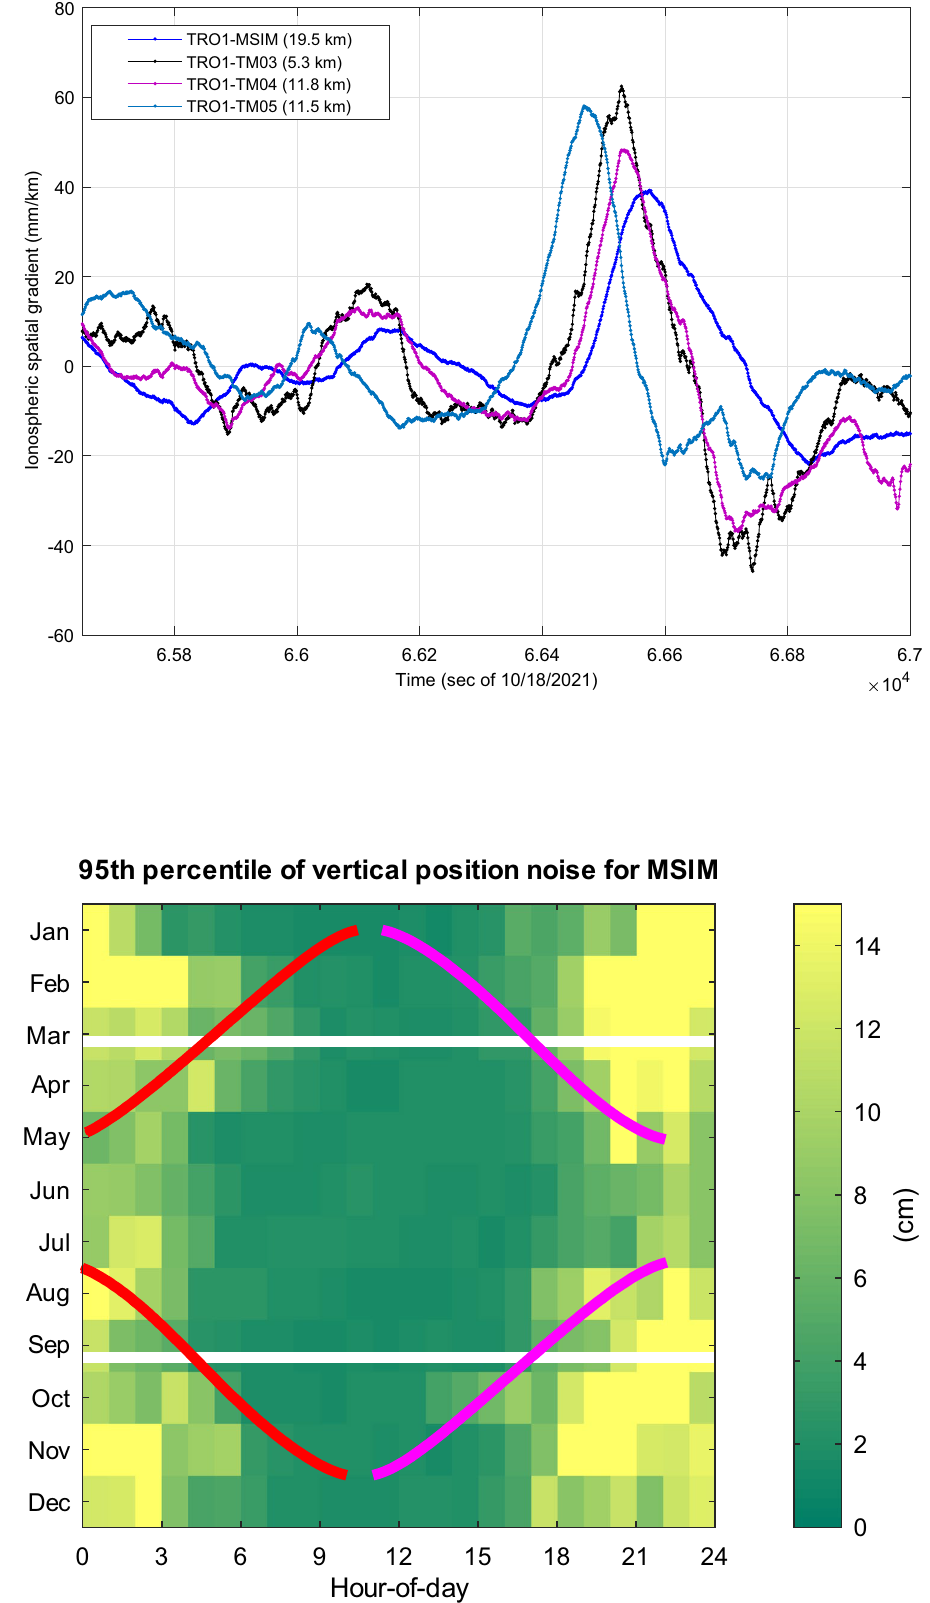
Fig. 6 Spatial decorrelation of ionospheric delay observed on the GPS PRN23 based on the TRO1 station and test receiver data